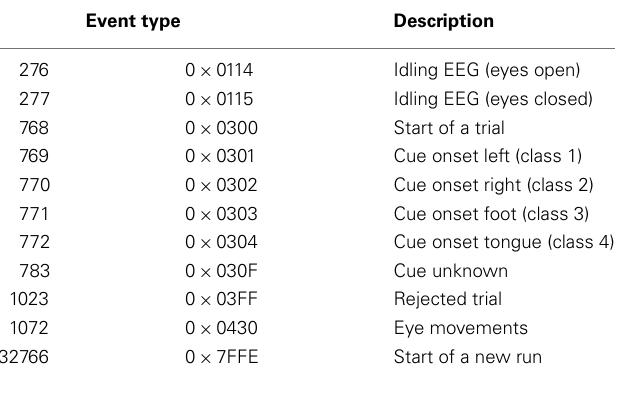
TableA2 | (Data Set 2a). List of event types in data set 2a (the first column contains decimal values and the second hexadecimal